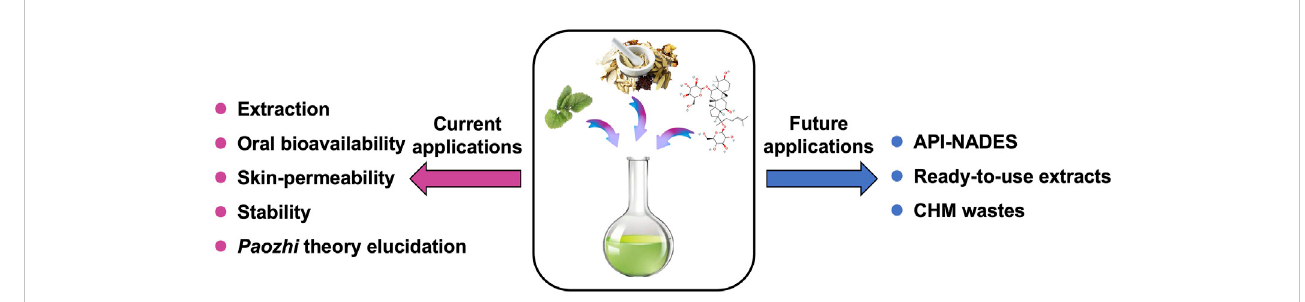
FIGURE 5 Current and future applications for NADES in CHMs. CHMs, Chinese herbal medicines; NADES, natural deep eutectic